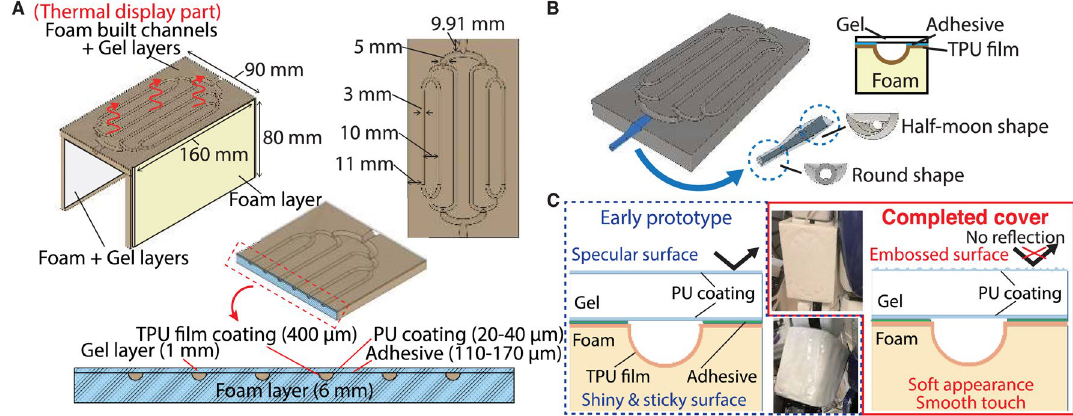
Figure 2. The structure of the robotic cover. ( A ) The cover consists of three sides: (1) the foam layer molded channels with the gel layer (proposed one), (2) the foam layer without channels covering the gel layer, and (3) the foam layer itself. The channels embedded with the foam layer are designed as branched into multiple lines to prevent water blockage. ( B ) Specific connectors are developed by 3D printing for the cover’s entrance and exit; the end in the robotic cover side is half-moon shape, smoothly circulating the water through the cover. The semi-circular channels’ surface built in the foam is coated by Thermoplastic Polyurethane (TPU) film (400 μm thickness) with PU coating (20–40 μm thickness), avoiding permeating the water into the foam layer. ( C ) Because the gel is transparent, the layer reflects an ambient light; it makes the surface glossy. Therefore, the PU coating has an embossed surface to absorb light so that the surface becomes smooth